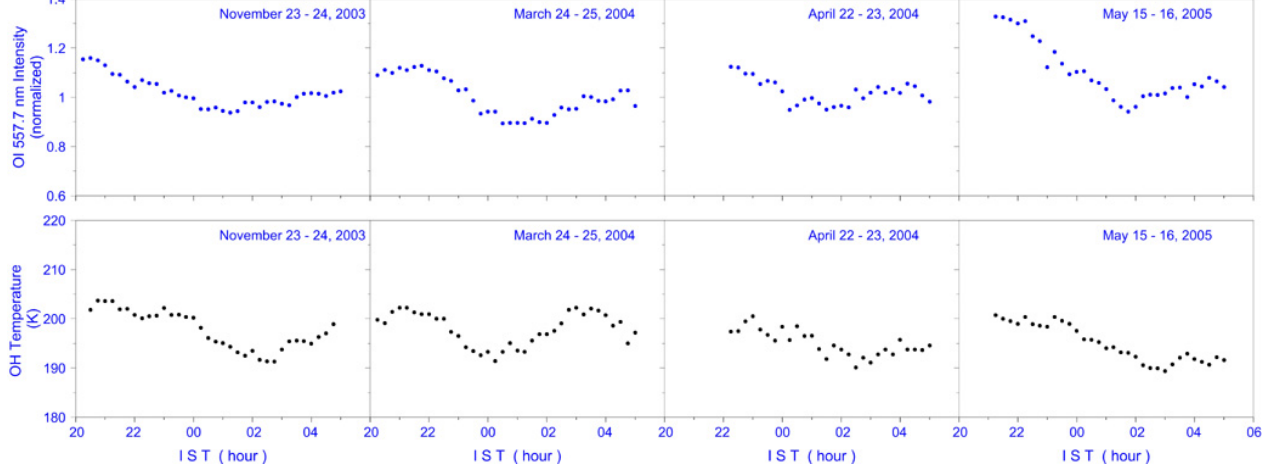
Fig. 2. Examples of the nocturnal trend of OI 557.7nm emission featuring the midnight minimum of intensity (top row). The nocturnal variation of the OH temperature on the corresponding night is shown in the bottom row.